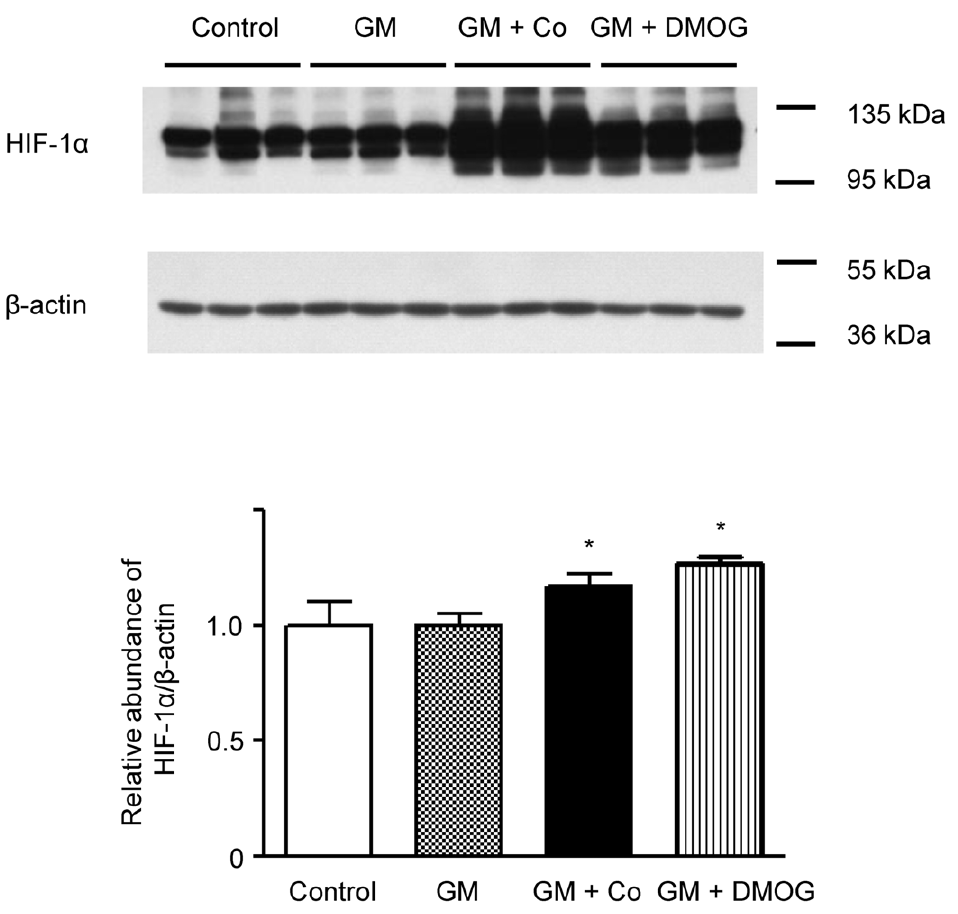
Figure 1. Activation of hypoxia-inducible factor (HIF) in HK-2 cells. Western blotting of HIF-1 a in HK-2 cells. HK-2 cells were pre-treated with 150 m M of cobalt or 1 mM of DMOG for 24 h and then treated with 3 mM of gentamicin for another 24 h. Beta-actin was used as a loading control. A representative set of three independent experiments is shown. Densitometric ratios between HIF-1 a and b -actin of cells are shown as the relative ratios of experimental groups compared with control cells. The results are expressed as the mean 6 s.d. *Significantly different with respect to control cells. * P , 0.05. GM, gentamicin treatment; GM + Co, cobalt pre-treatment and gentamicin treatment; GM + DMOG, DMOG pre-treatment and gentamicin